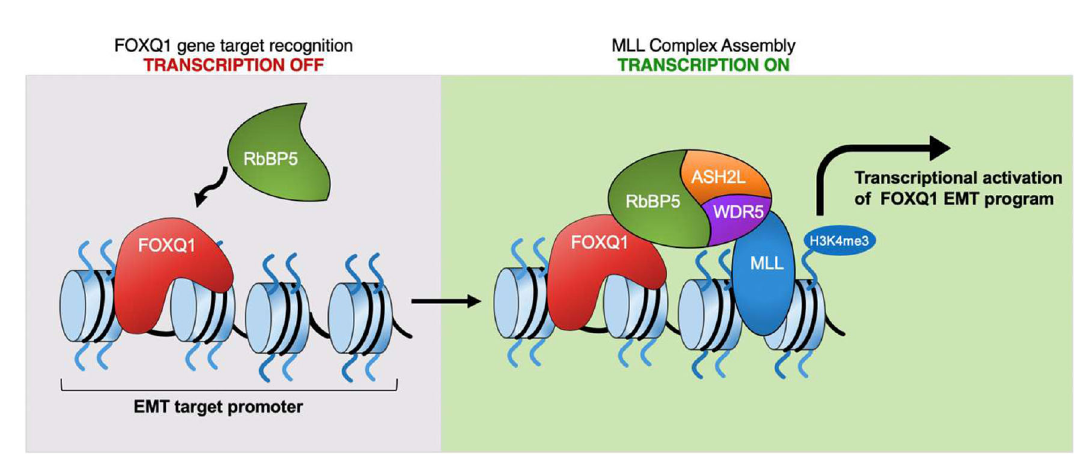
Fig. 9 | Schematic illustration of the mechanism of FOXQ1 transcriptional regulation. AproposedmodelillustratesthatFOXQ1directlyrecruitsRbBP5tothe